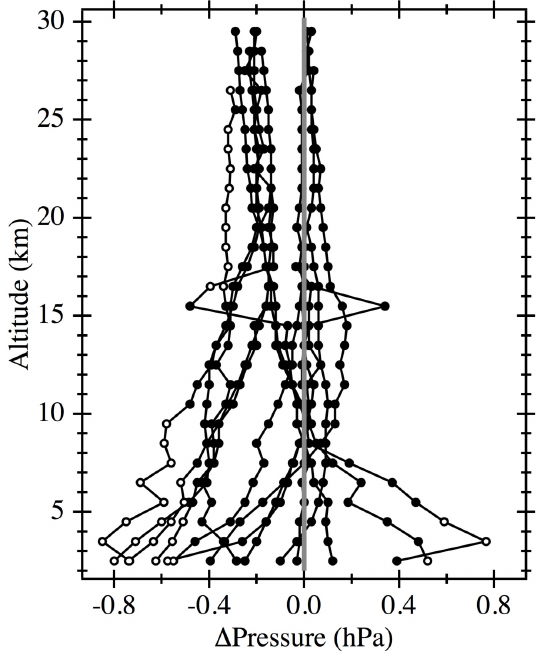
Fig. 7. The 14 1P profiles for paired RS92 sondes. None stand out as anomalous and only 11% of 1P exceed the manufacturer- quoted limits (1 σ ) for P measurement reproducibility in Table 2.